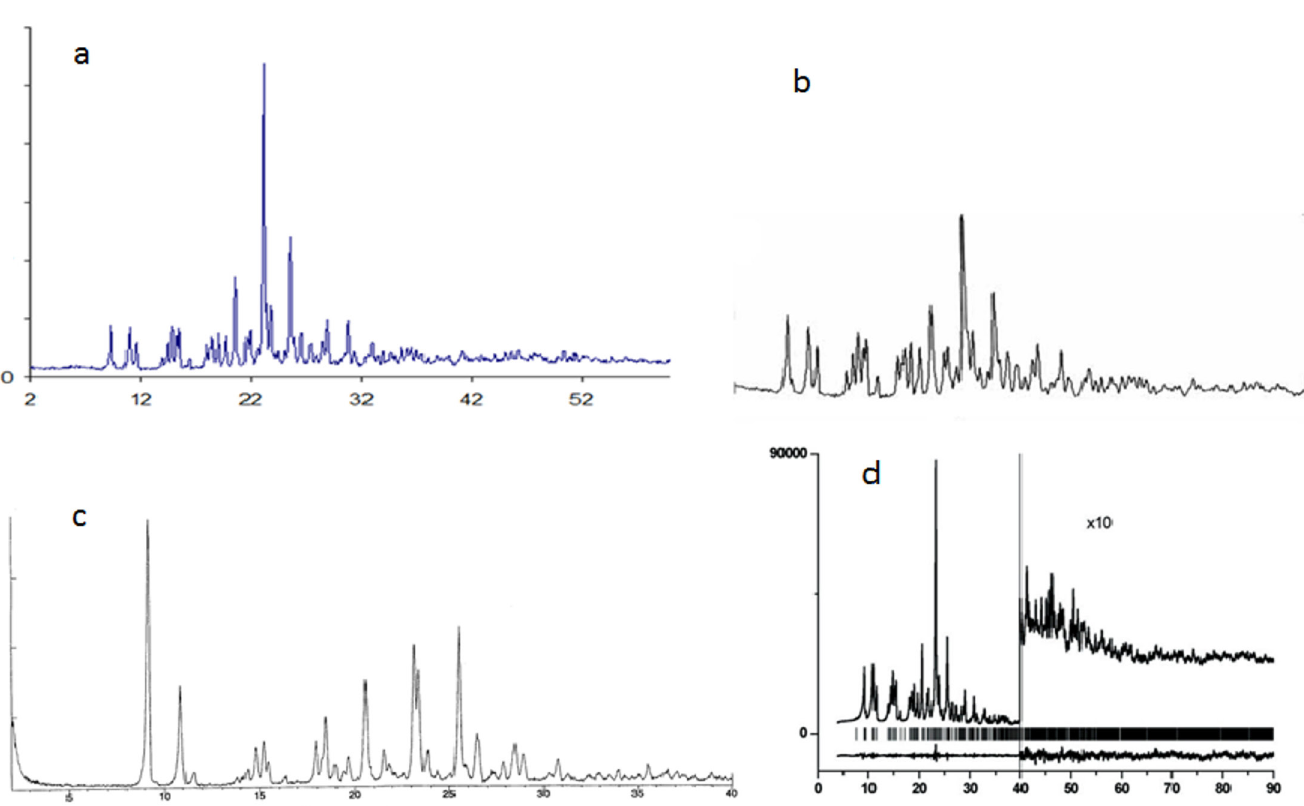
FIGURE 7 – PXRD patterns for form I of clopidogrel bisulfate: a) commercial samples; b) adapted from Koradia, Chawla, Bansal, 2004, c) adapted from PI9911219 – (Bousquet, Castro, Saint-Germain, 2001) and d) adapted from the IUCr database (Chernyshev et al. ,